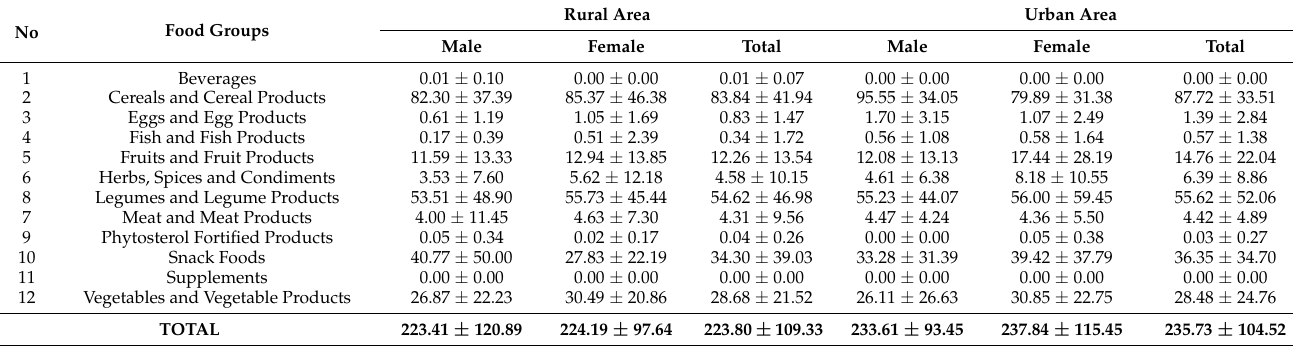
Table 4. The contribution of each of the food groups to plant sterol intake in the rural and urban population (mg/person/day).